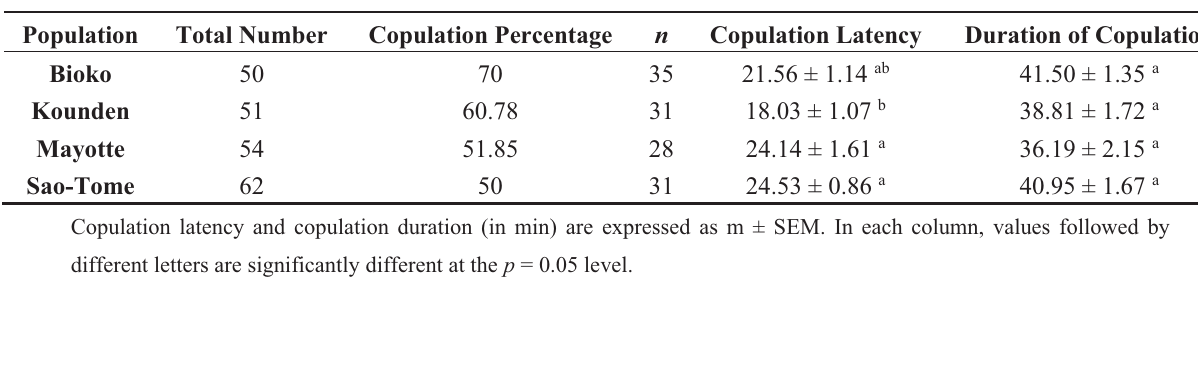
Table 3. Mating behavior parameters of D. yakuba